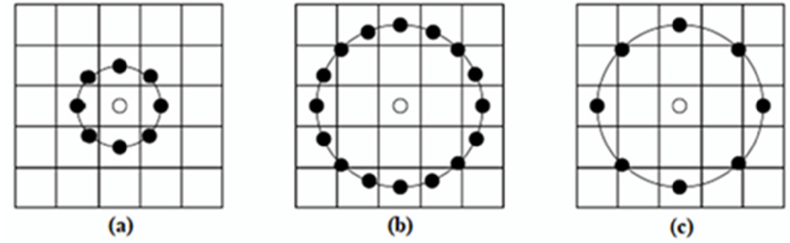
Figure 4. Circular LBP examples. ( a ) r = 1, n = 8 ( b ) r = 2, n = 16 ( c ) r = 2, n = 8.